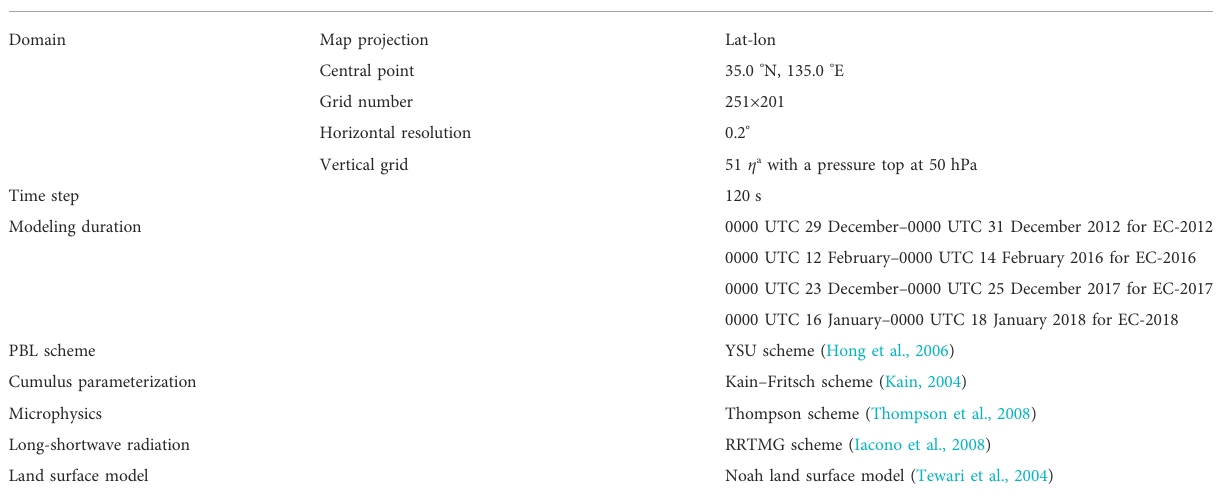
TABLE 1 Con fi guration for WRF